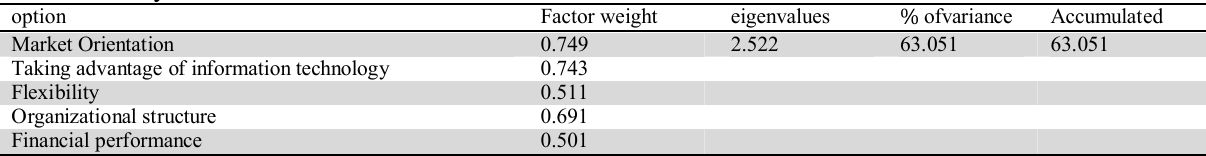
The summary of factors associated with flexible structure option